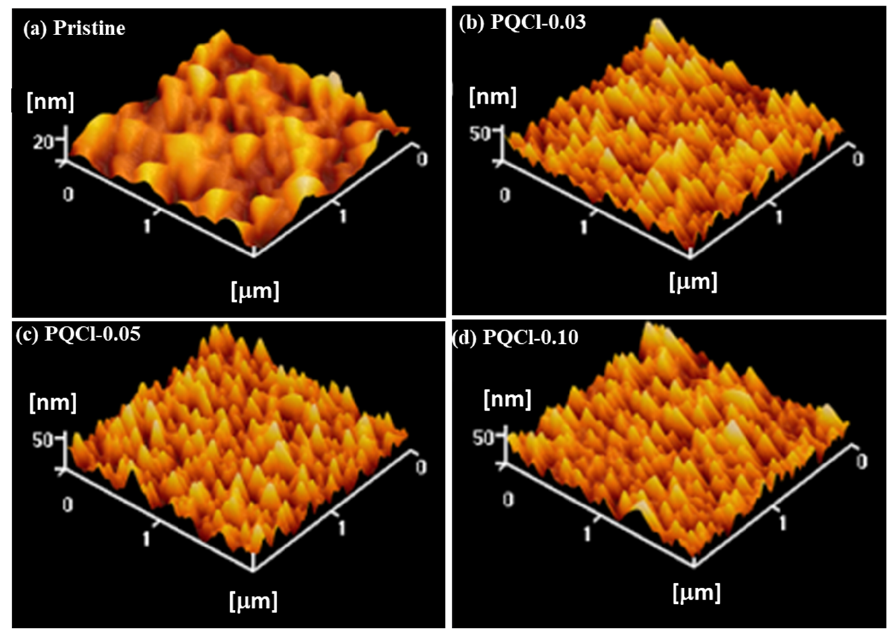
Figure 3. Topographic images of PQCl-deposited NiO x layers: ( a ) pristine, ( b ) PQCl-0.03, ( c ) PQCl- 0.05, and ( d ) PQCl-0.10.